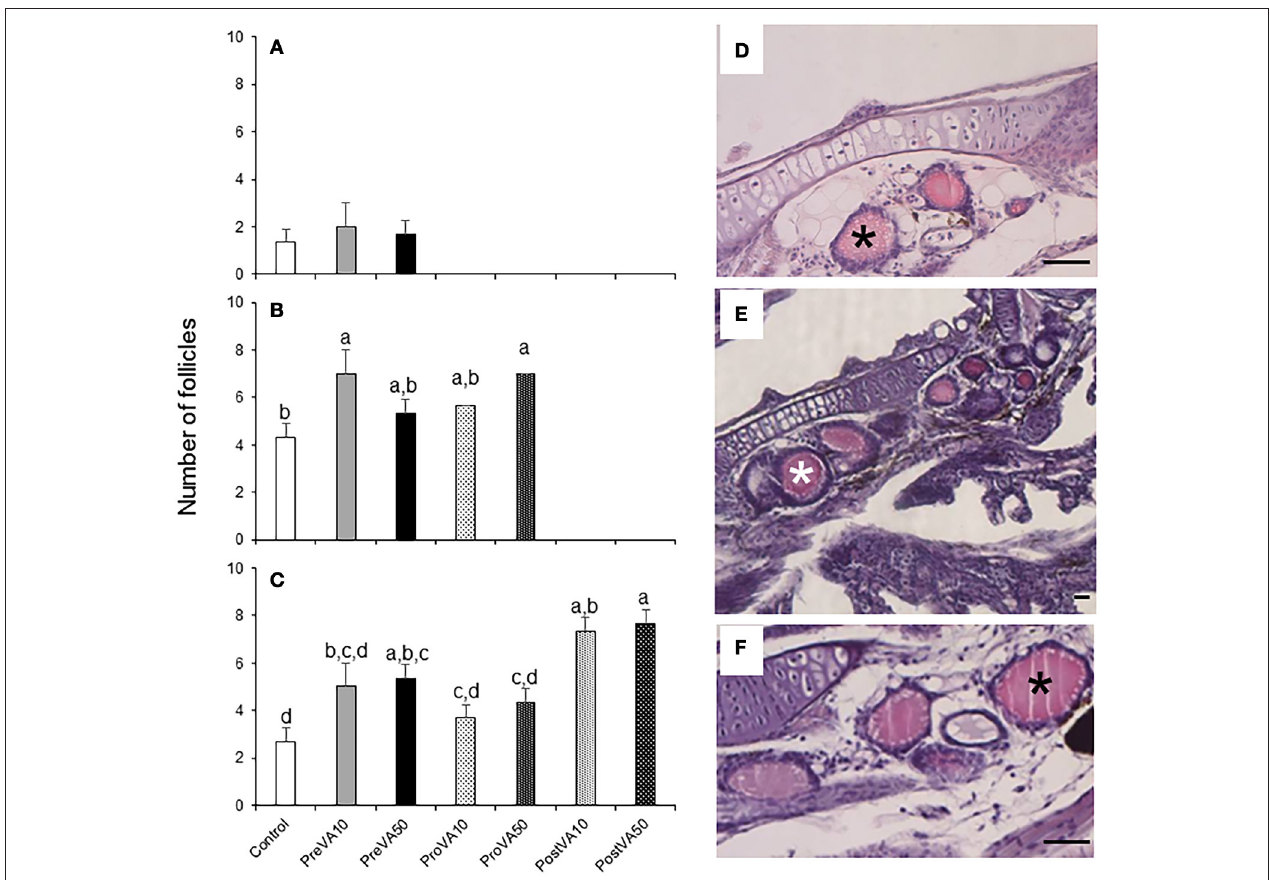
FIGURE 7 | Number of follicles of the thyroid gland (mean ± standard deviation) in Senegalese sole fed with experimental diets at 10 (A) , 21 (B) , and 55 (C) dph. A detailed view of the number of thyroid follicles (black or white asterisks) in a Control (D) , PreVA10 (E) , and PreVA50 (F) larvae at 21 dph. For a detailed description about the different experimental groups, please see the legend of Figure 1 . Different letters at the top of each bar denotes statistically significant differences among experimental groups (ANOVA, P < 0.05; N = 3). Scale bar = 200 µ